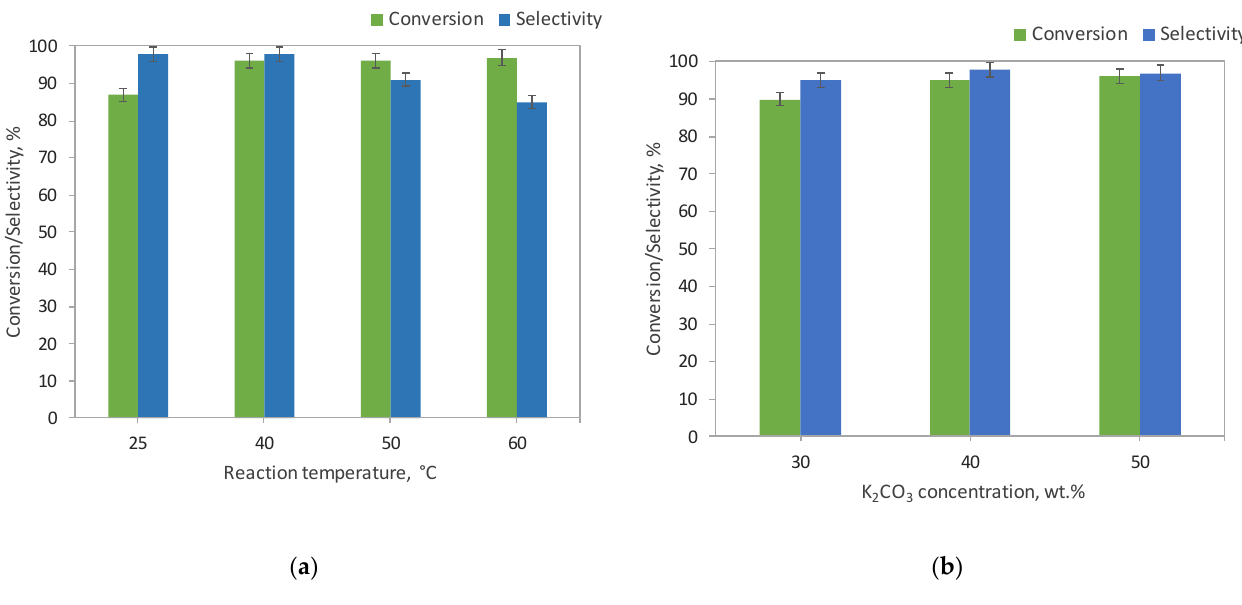
Figure 2. The effect of ( a ) temperature; ( b ) K 2 CO 3 concentration, on hydroxypivaldehyde synthesis. Reaction conditions: ( a ) 40 wt.% K 2 CO 3 ; PEG 600-PS, 0.5 mol%; 600 rpm; 2 h; ( b ) K 2 CO 3 ; PEG 600-PS, 0.5 mol%; 40 ◦ C; 600 rpm; 2 h. Each experiment was performed three